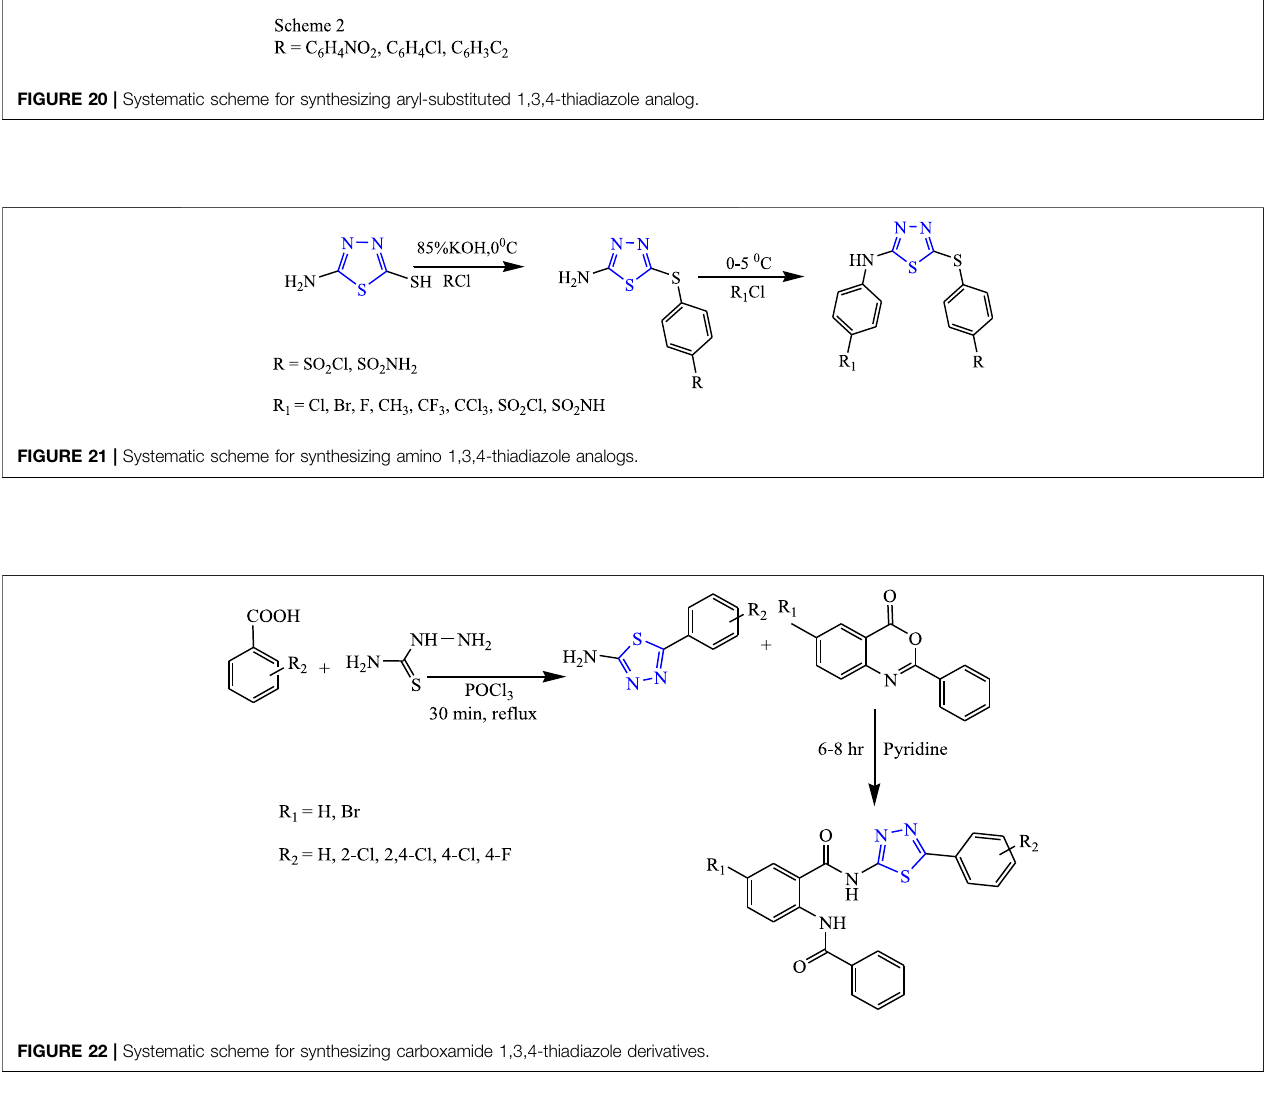
Frontiers in Chemistry |